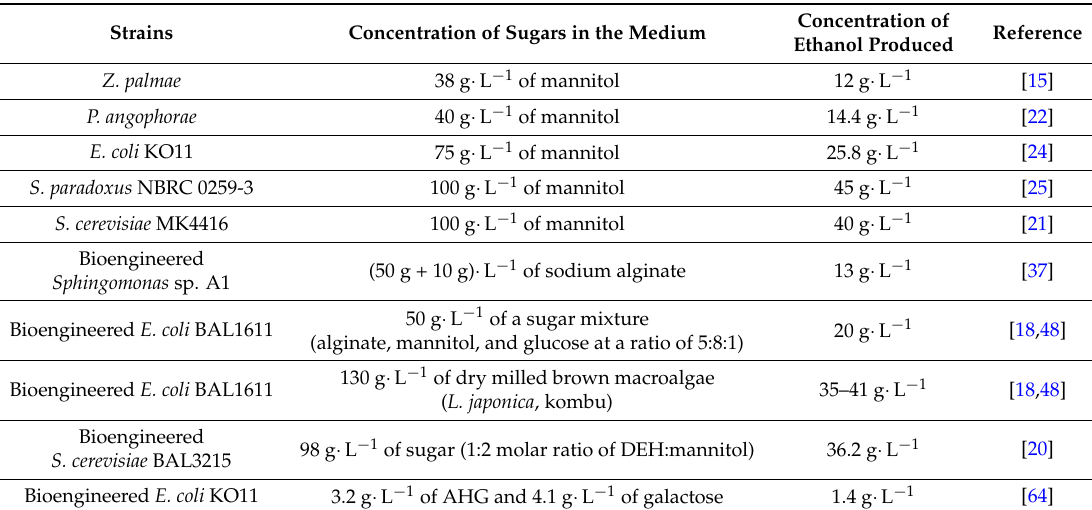
Table 5. Summary of the ethanol production in this